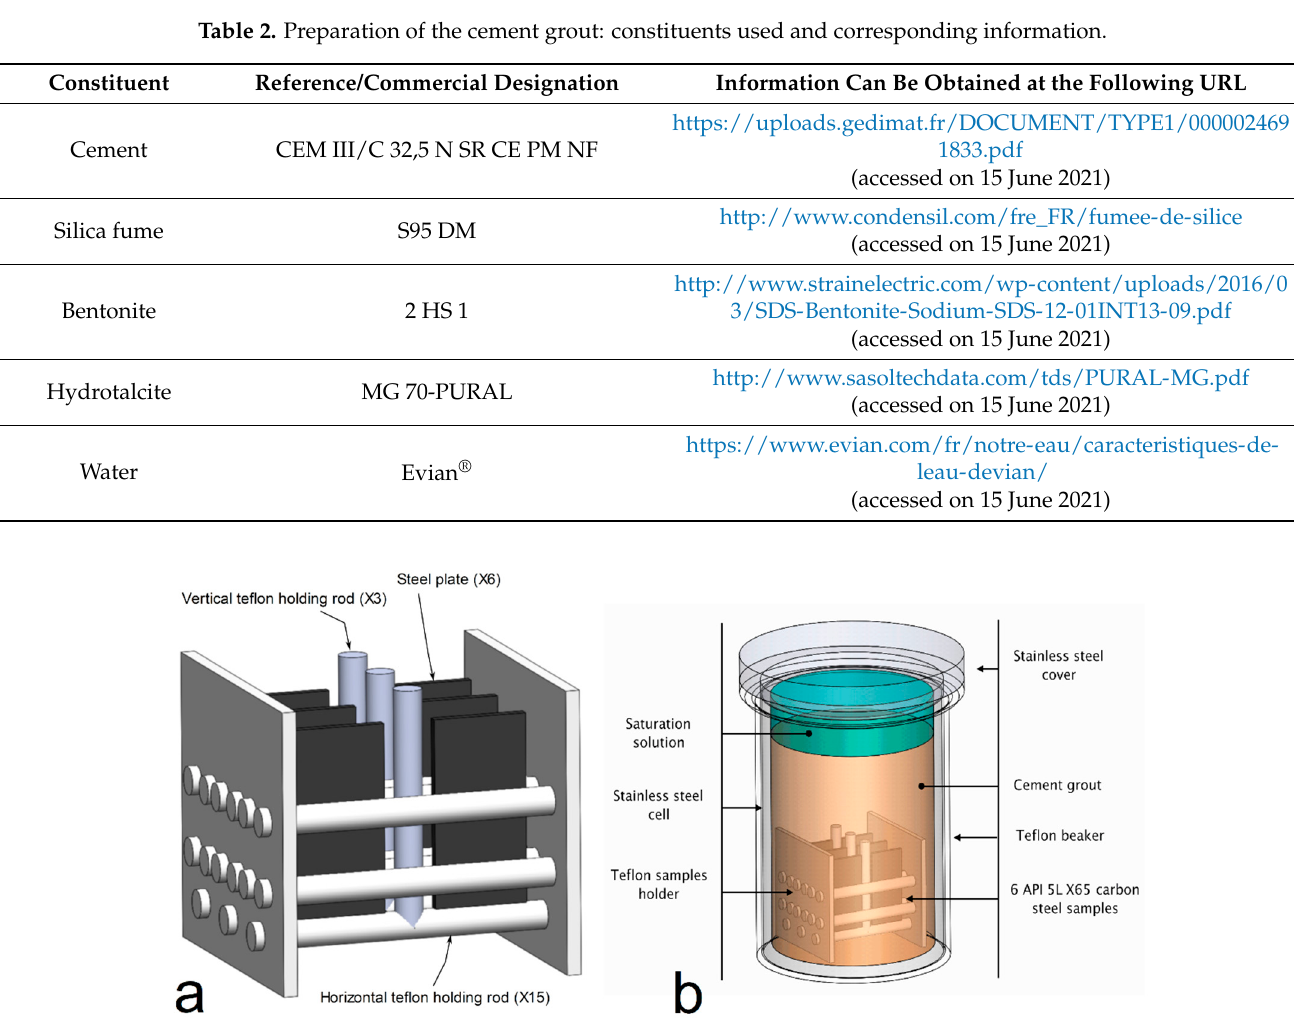
Figure 2. Schematic representation of ( a ) the Teflon sample holder with 6 carbon steel samples and ( b ) schematic view of the test cell.